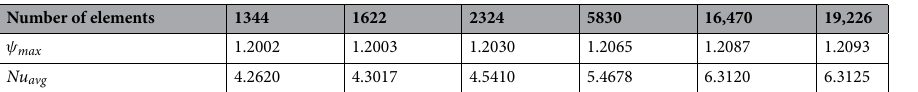
Table 2. Grid dependency of ψ max , and Nu avg at the heated wall when Ra = 10 6 , Ha = 0 , Da = 0.01 , ε = 0.2 , φ = 0.02 , r = 0.1 , ω = 0 and N = 4